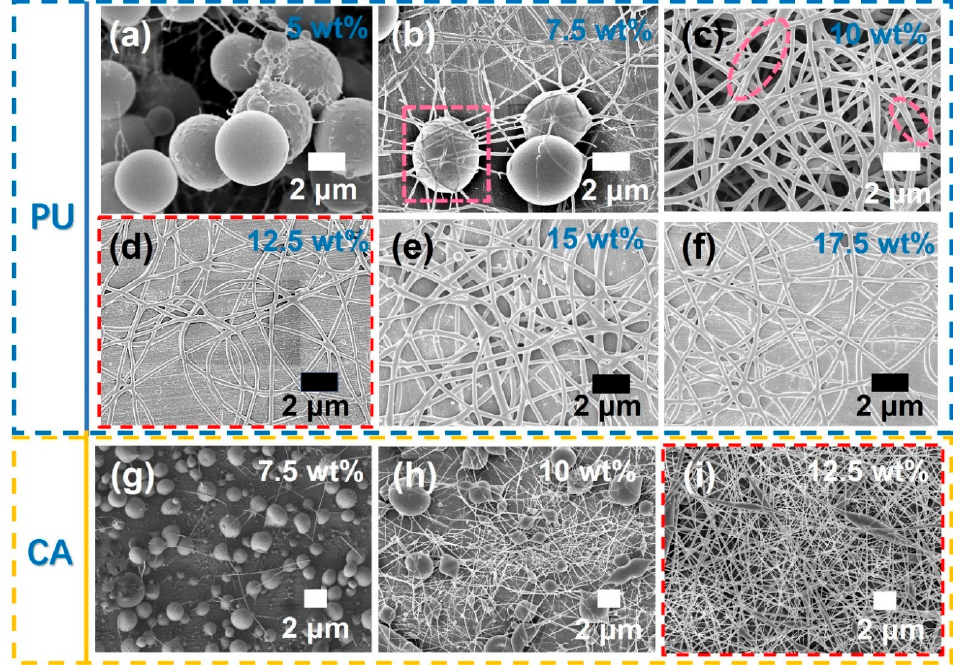
Figure 2. Scanning electron microscope (SEM) images of PU and CA fibrous membrane. PU / (DMF:THF = 9:1) = ( a ) 5 wt %; ( b ) 7.5 wt %; ( c ) 10 wt %; ( d ) 12.5 wt %; ( e ) 15 wt %; ( f ) 17.5 wt %. CA / (Ac:DMF) = ( g ) 7.5 wt %; ( h ) 10 wt %; ( i ) 12.5 wt